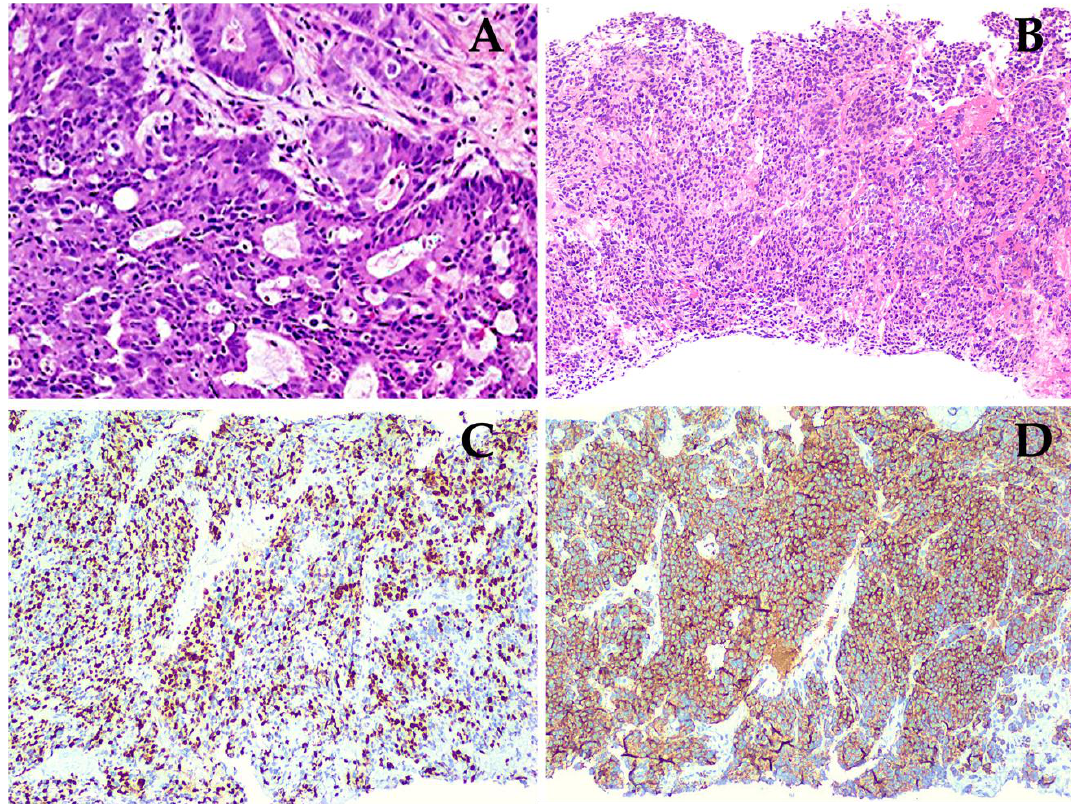
Figure 1. Patient number 2: ( A ) Image of a slide of the initial biopsy, with a 20x zoom, stained with hematoxylin and eosine (H&E), revealing a prostate mucinous adenocarcinoma, in which mucinous component is predominantly composed of cribriform glands, with a Gleason score of 8 (4 + 4). ( B ) Image of a pulmonary metastasis biopsy of the same patient, performed after therapy, also stained with H&E, with a 10x zoom lens, showing a neoplastic lesion, with an organoid pattern (sheet–like tumor nests); cells are large, with a variable shaped nuclei, fine granular chromatin, and a small nucleolus, scant clear to eosinophilic cytoplasm, some cells with marked pleomorphism, atypical mytotic figures, and apoptotic bodies. ( C ) Ki67 immunohistochemistry (IHC), evidentiating a positive nuclear reaction in 70% of the cells, with an intense and diffuse granular cytoplasmatic staining. ( D ) Synaptophysin positive IHC.